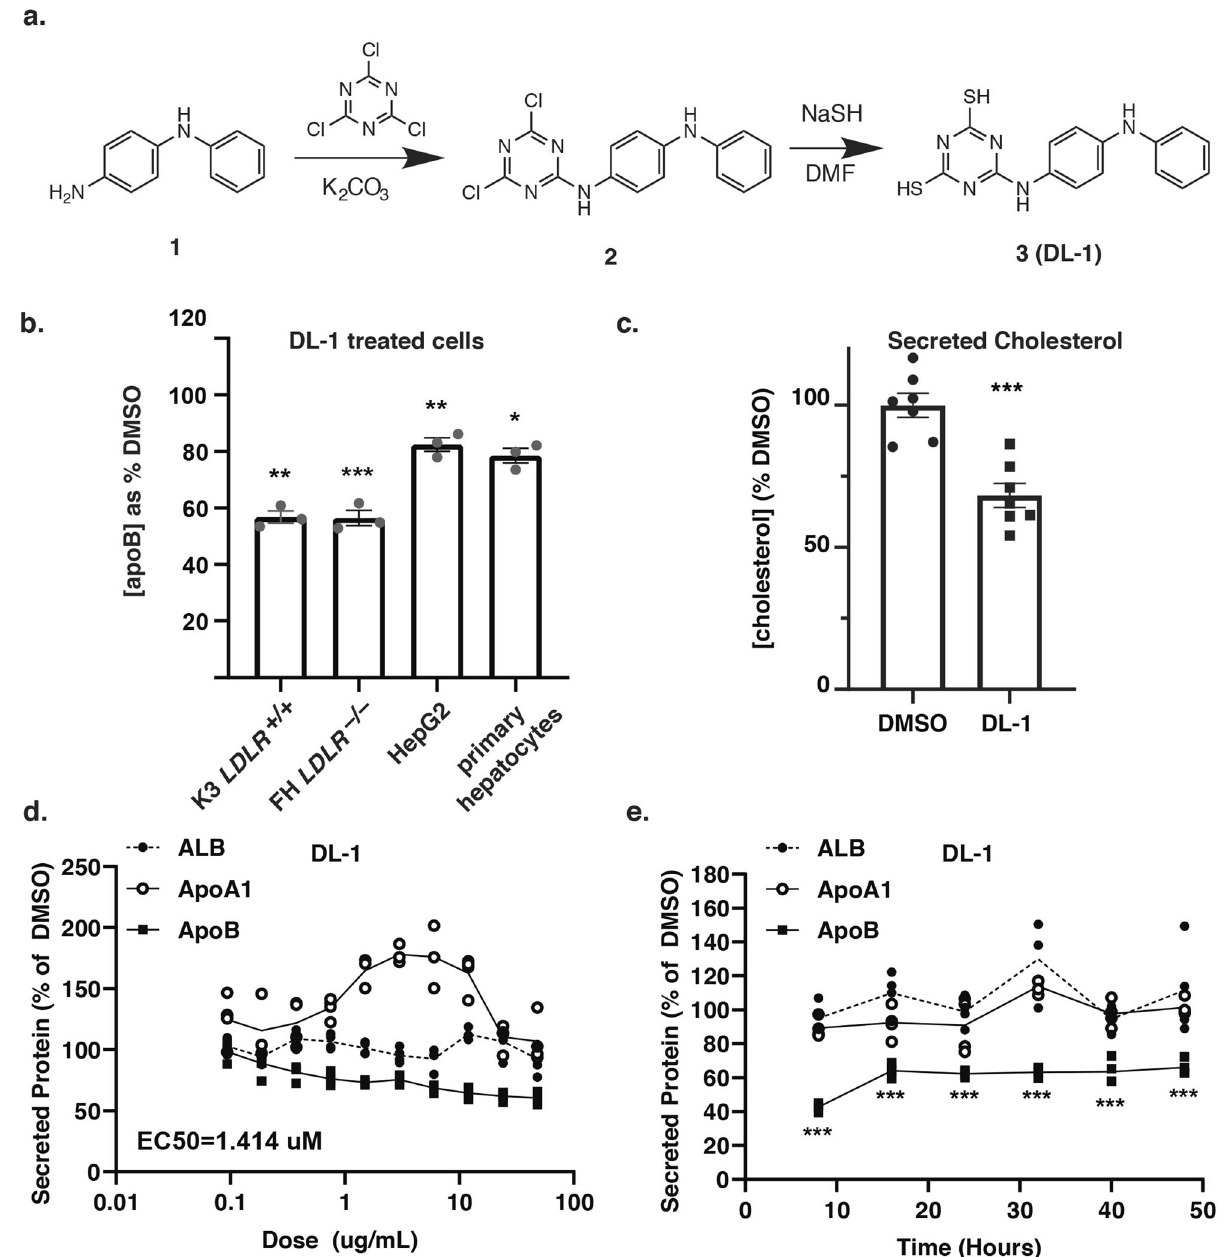
Fig. 4 Compound DL-1 reduced apoB and cholesterol in hepatocyte culture medium. a The structure and synthesis of the lead compound DL-1 (formerly SC3-01). N -phenyl-1,4-benzenediamine (1) was reacted with cyanuric chloride in the presence of anhydrous potassium carbonate to form the intermediate compound (2). The latter reacted with sodium hydrosul fi de (NaSH) in dimethylformamide (DMF) to form compound (3), DL-1. b Human iPSC-hepatocytes from a healthy donor (K3) and hoFH patient (JD4) along with human primary hepatocytes and HepG2 cells were treated with 2 µ g/ml of DL-1 and compared to vehicle-treated cells (DMSO; 100%) for 24 h. ApoB levels in the medium were determined by ELISA ( n = 3). c Graph showing the total cholesterol levels in the cell culture medium as determined by a cholesterol colorimetric assay. Pre:post treatment levels were compared to the DMSO- treated control group ( n = 7). d Human iPSC-hepatocytes were treated with DL-1 with concentrations ranging from 0.0325 to 48 µ g/ml for 24 h. Albumin, apoA1, and apoB levels in the culture medium were determined by ELISA assay ( n = 3). e Cells were treated with 2 µ g/ml of DL-1 from 8 to 48 h and pre- drug and post-drug medium was collected for analysis. The concentration of Albumin, apoA1, and apoB in the culture medium was determined by ELISA ( n = 3). Secreted protein levels were compared to DMSO-treated cells. Data are shown as mean ± SD. All statistical analysis was performed using Student ’ s t test or one-way ANOVA followed by Dunnett ’ s test as appropriate; * p < 0.05, ** p < compounds (DL-2 through DL-21) with ≥ 40% similarity to DL-1. stand the structure-activity relationship, iPSC-hepatocytes were treated with each of the twenty analogs of DL-1 at 2 µg/ml for 24 h before measuring the impact on apoB levels in the medium.